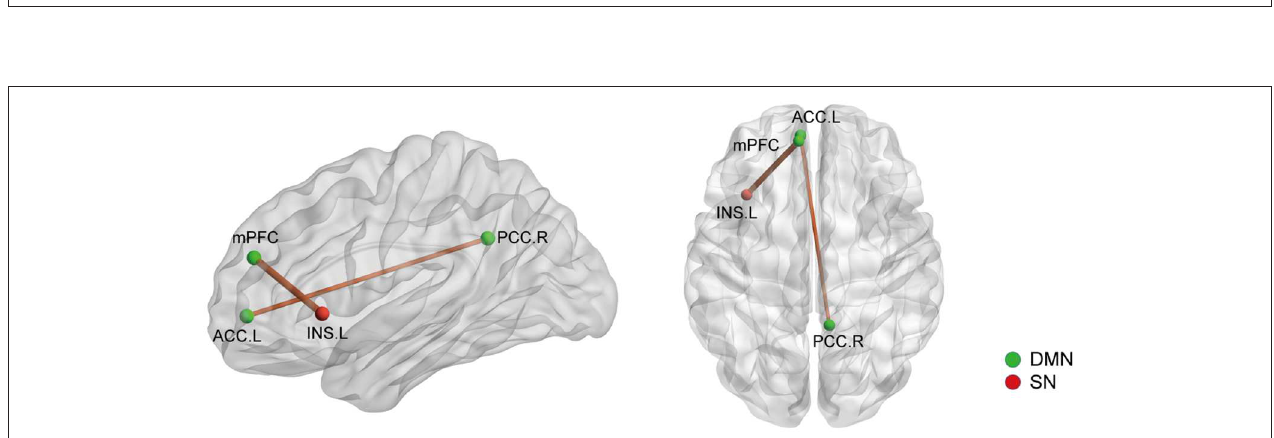
FIGURE 4 | The relationship between significant nodal properties (BC and DC) and pain or fatigue as measured by TBP or FSS( p < 0.05, Bonferroni corrected): (A) BC of node 115 (mPFC) was positively associated with both pain and fatigue; (B) BC of node 208 (INS.L) and DC of nodes 165 (CERE.R) and 172 (FFG.L) were positively associated with fatigue; (C) BC of node 41 (PreCG.R) and DC of node 263 (SPG.L) were positively associated with fatigue. mPFC, medial prefrontal cortex; INS.L, left insula; CERE.R, right cerebellum; FFG.L, left fusiform gyrus; PreCG.R, right precentral cortex; SPG.L, left superior parietal gyrus.